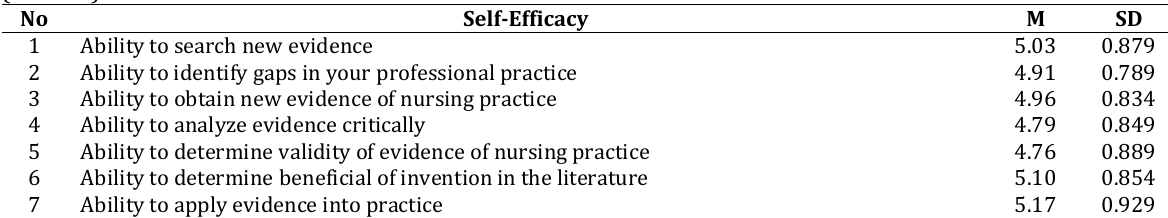
Table 3. Mean score and standard deviation of students’ self-efficacy in implementing EBP in clinical practice (n = 120)